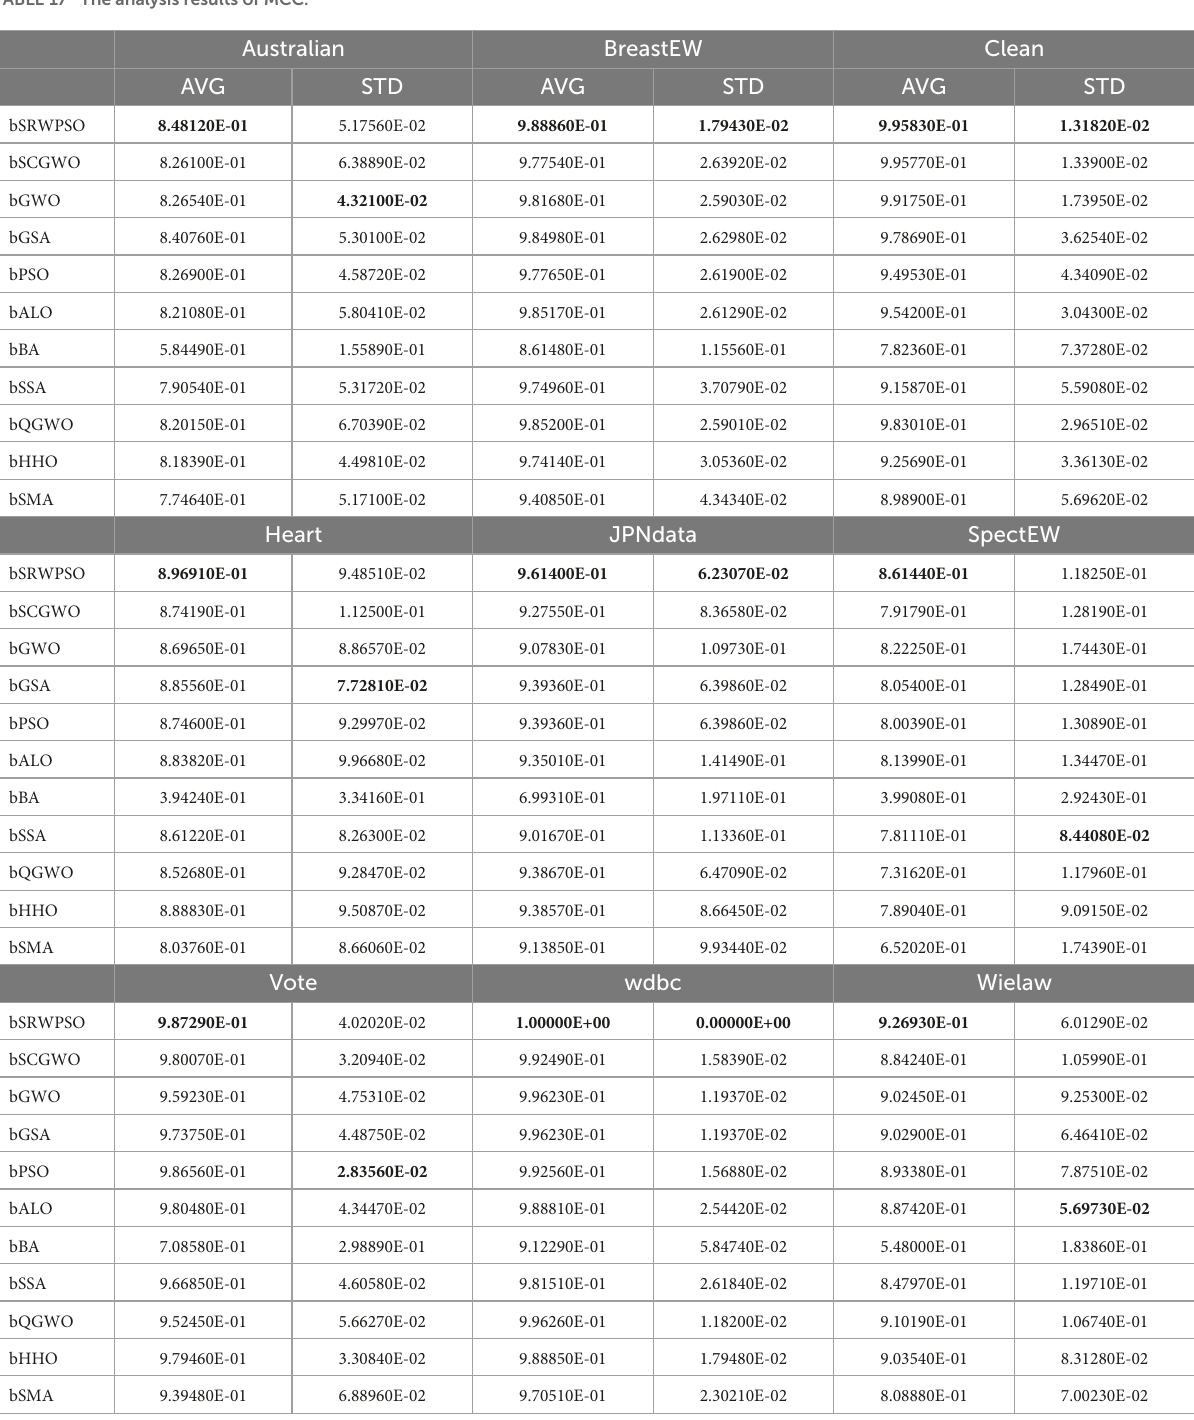
TABLE 17 The analysis results of